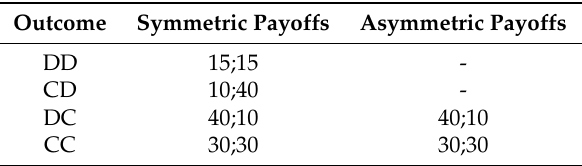
Table 1. Prisoner’s Dilemma